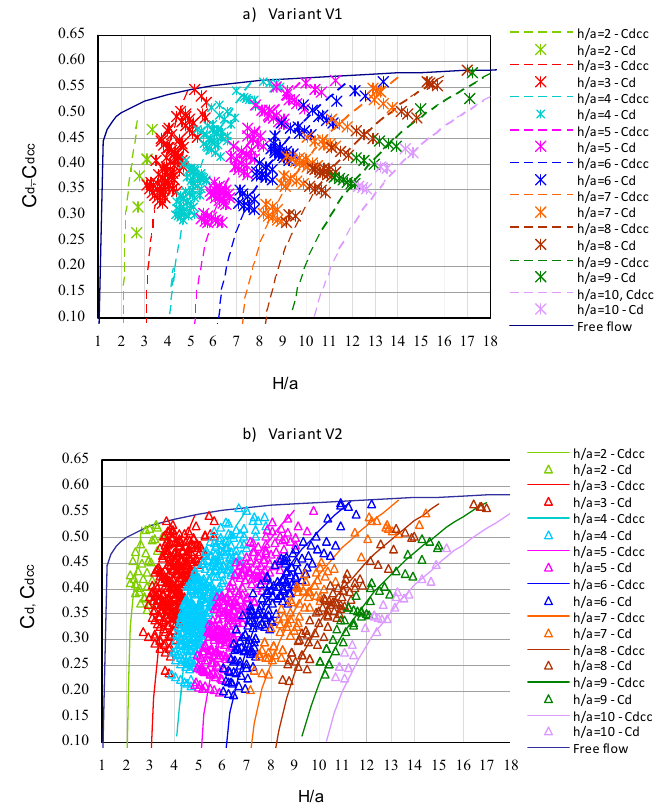
Figure 13. Discharge coe ffi cients obtained from measurements C d and calculated using Equation (5) with correction (11-12) C dcc for: ( a ) case V1; ( b ) case